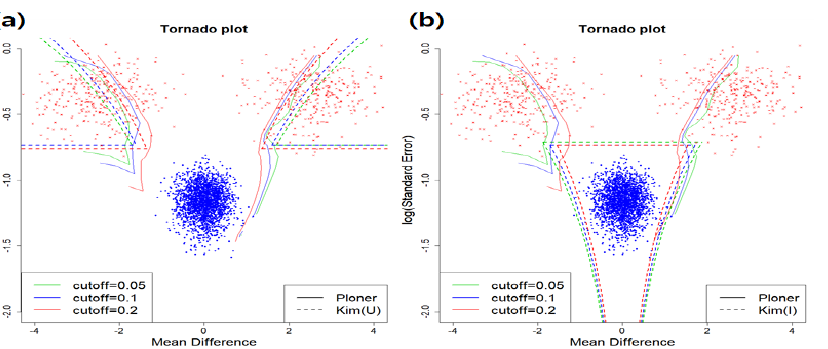
Figure 10. Scale change scenario and two-sided. Estimated fdr2d when k = 4: ( a ) Union null ( b ) Intersection